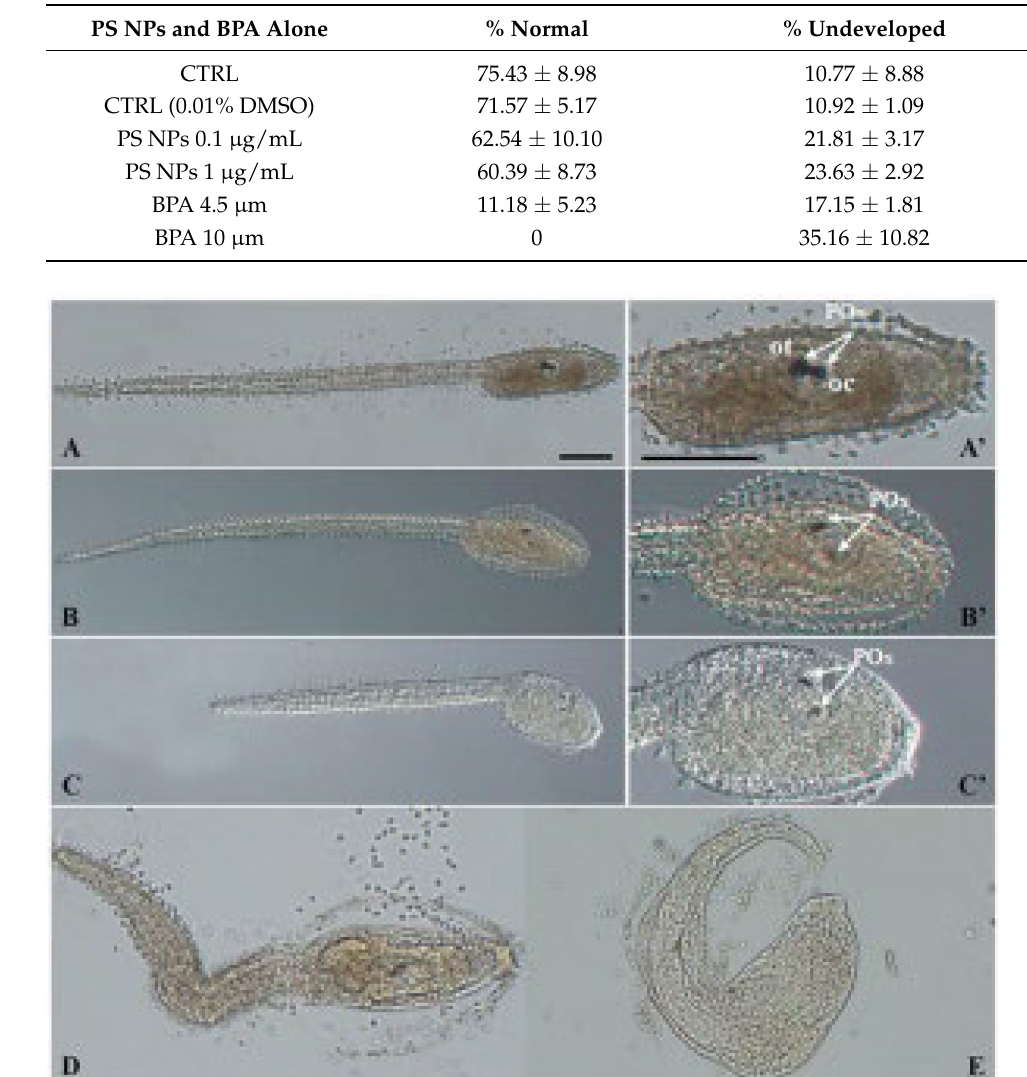
Table 2. The percentage (%) of normal hatched larva and undeveloped embryos of C. robusta upon single exposure to non-functionalized PS NPs and BPA in FSW.